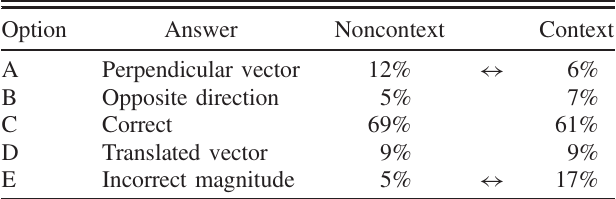
TABLE XIII. Results of item 8: Students have to choose the representation of vector − 3 A or velocity − 3 v . Arrows indicate significant